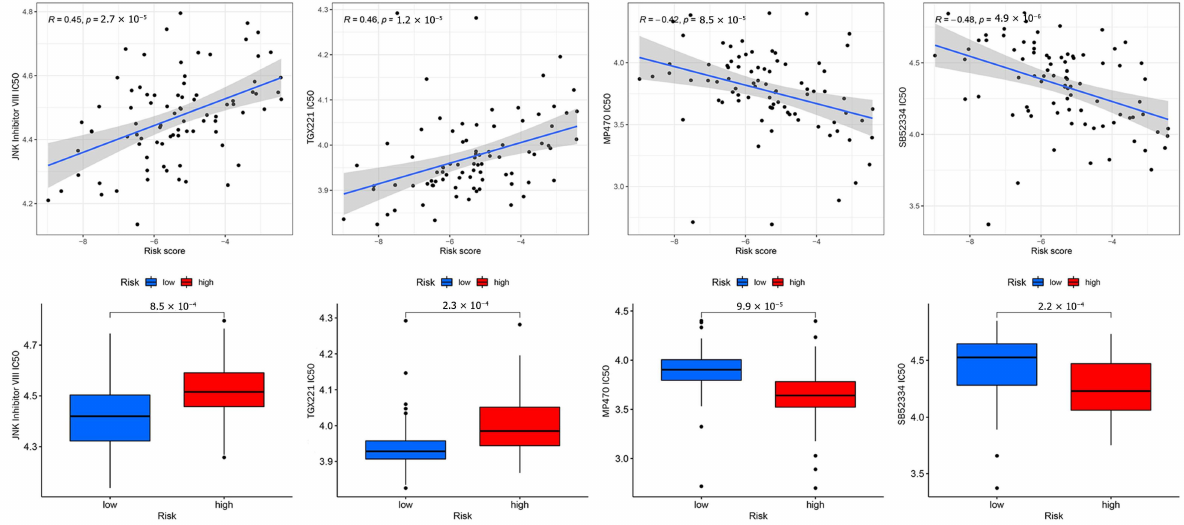
Figure 15. DrugcorrelationandsensitivityanalyseswithJNKInhibitorVIII,TGX221, MP470, and